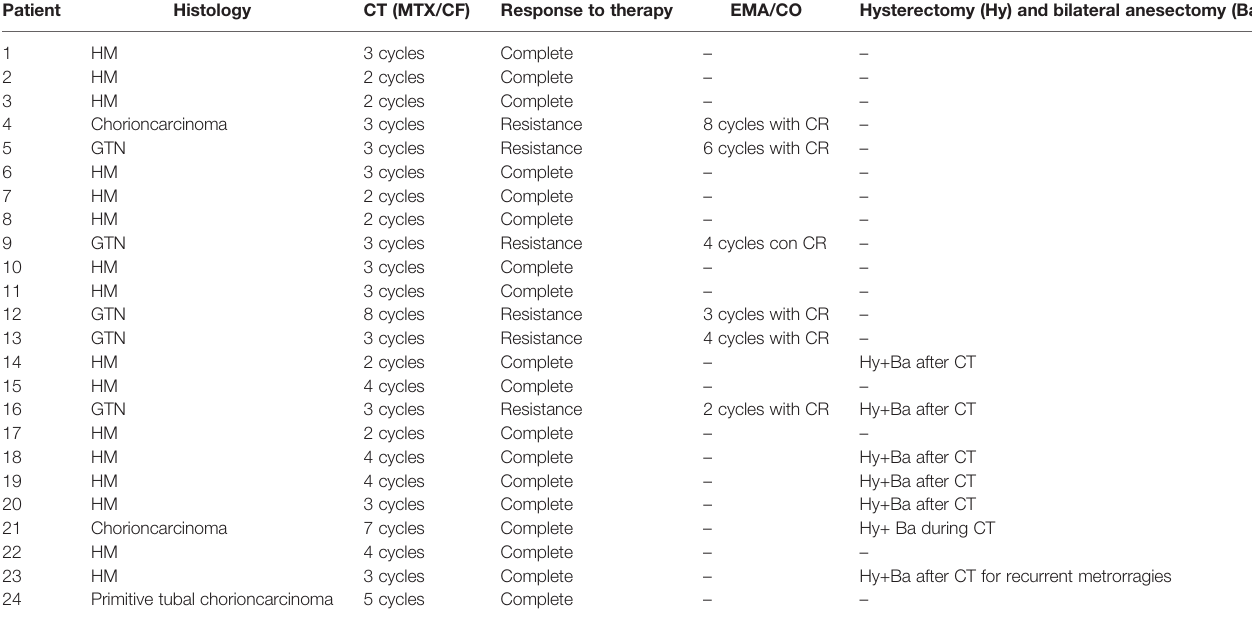
TABLE 2 | Patients treated by fi rst-line (MTX/CF) and second-line (EMA/CO) chemotherapy. CT).